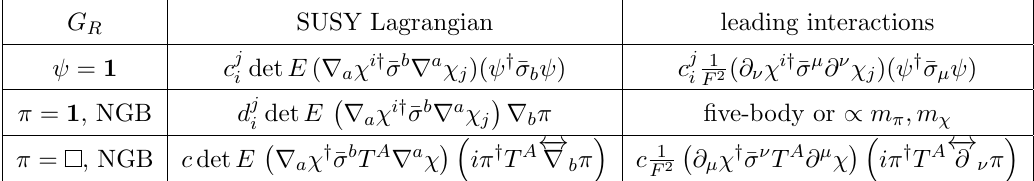
Table 2 . Model dependent couplings. For composite particles c j